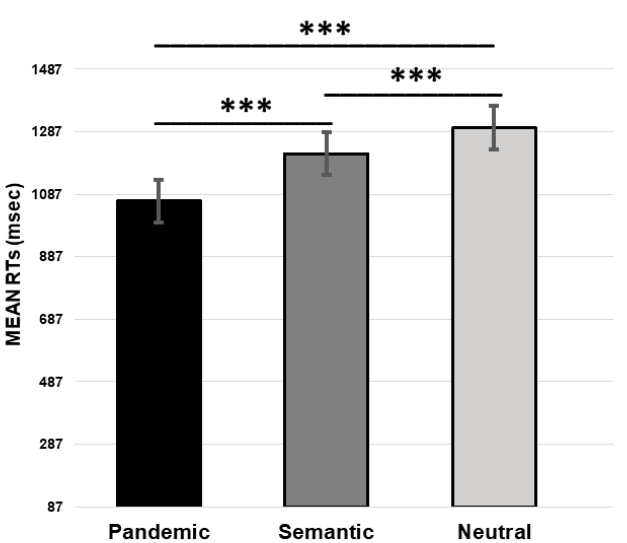
Figure 2. Mean percentage of reaction times (RTs) for pandemic, semantic, and neutral stimuli (*** p ≤ 0.001).